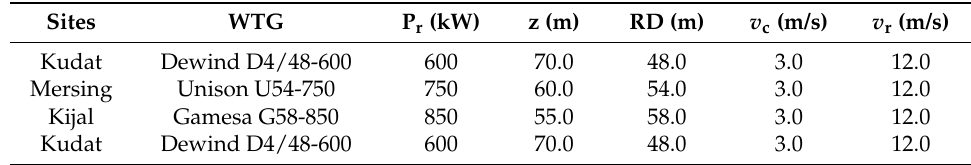
Table 4. The specification of four selected wind